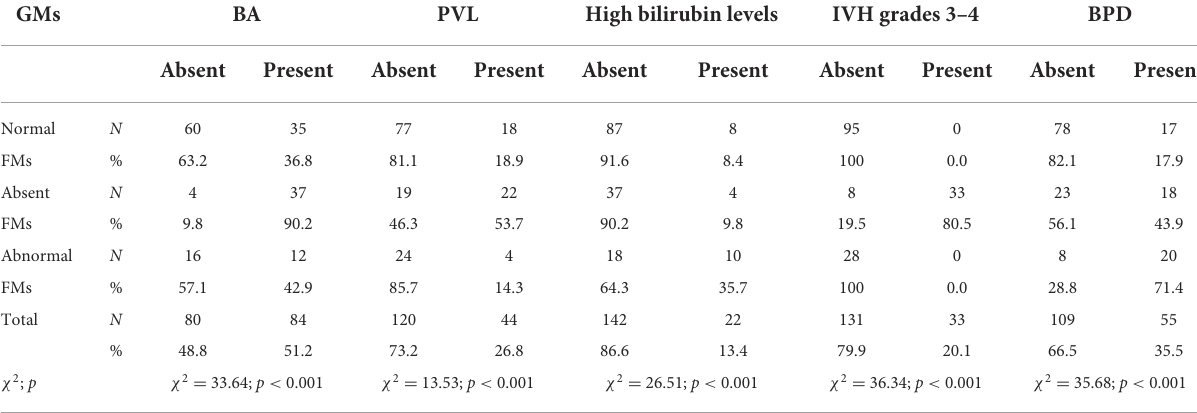
TABLE 4 Chi-squared distribution table for the association between postnatal risk factors and a particular general movement (GM) pattern. GMs BA PVL High bilirubin levels Absent Present Absent Present Absent Present Absent Present Absent